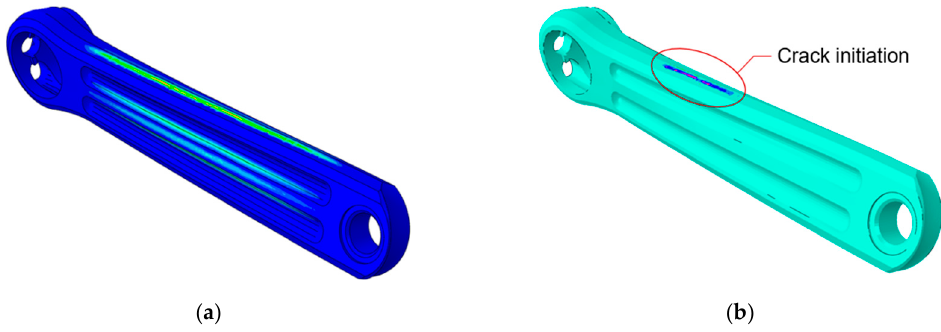
Figure 22. ( a ) Permanent deformation and ( b ) scalar stiffness degradation of the new crank arm model.